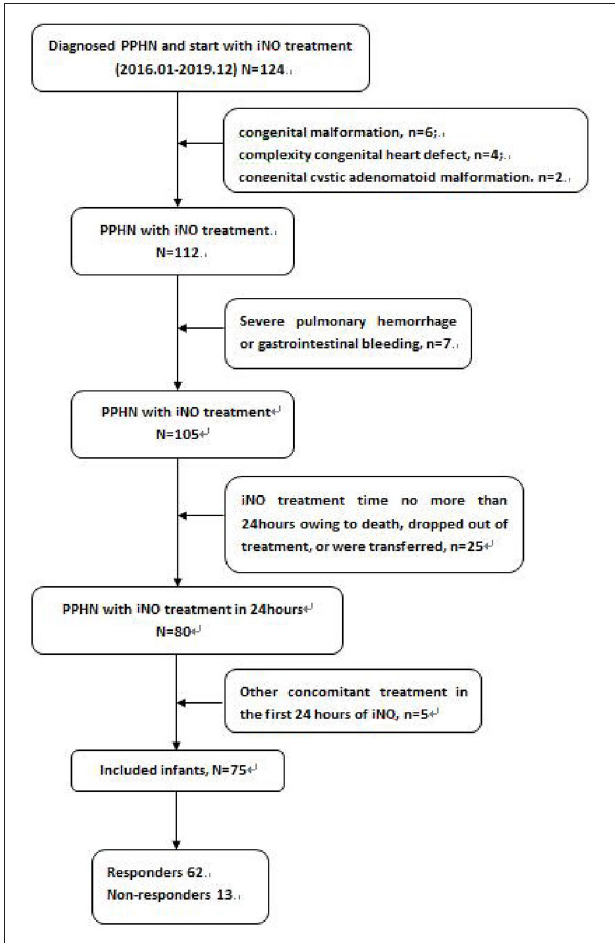
FIGURE 1 | Included patients process.